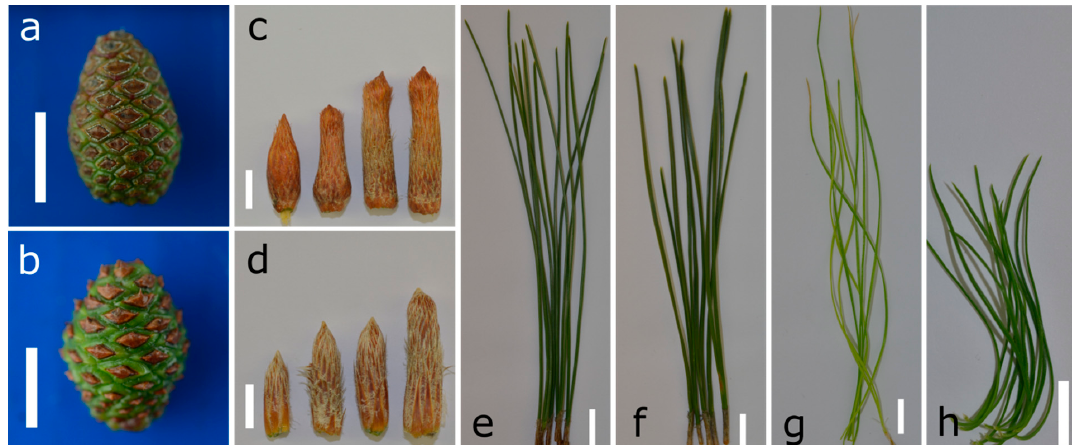
Figure 2. Representative images of tissue samples collected. ( a ) P. massoniana cone (MCN); ( b ) Z pine cone (ZCN); ( c ) young stem of P. massoniana (MYS); ( d ) young stem of Z pine (ZYS); ( e ) mature needle of P. massoniana (MMN); ( f ) mature needle of Z pine (ZMN); ( g ) young needle of P. massoniana (MYN); ( h ) young needle of Z pine (ZYN). Scale = 10 mm.